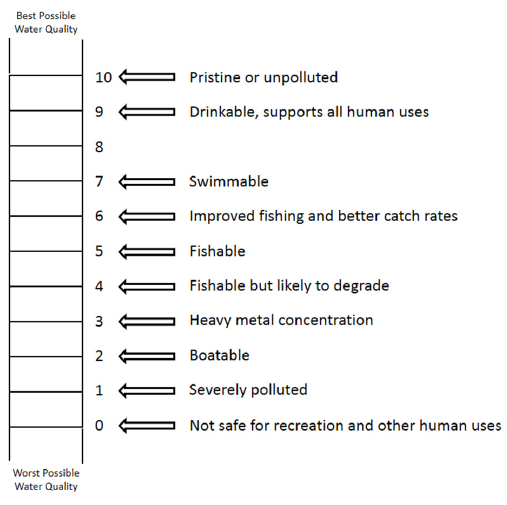
Figure 2. Water Quality Ladder.